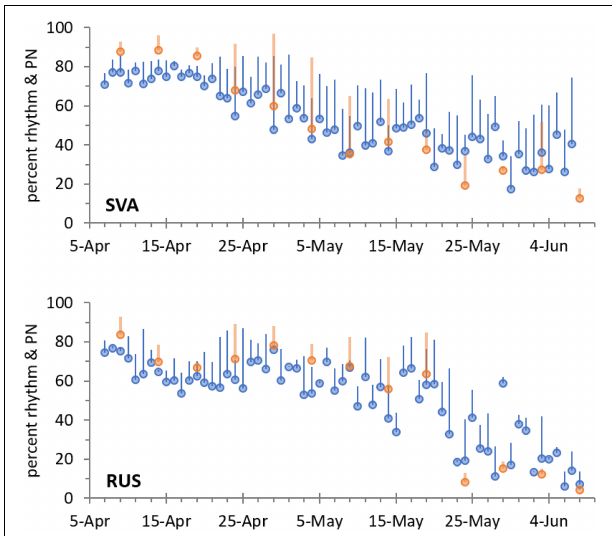
FIGURE 3 | Course of circadian rhythmicity of Tb in barnacle geese during spring, encompassing the time before, during, and after migration to their Arctic breeding grounds in Svalbard (SVA) and Russia (RUS). Plotted are percent rhythm (mean + SD over individuals, blue symbols) calculated from daily cosinor analysis, and normalized power (PN, mean + SD over individuals, orange symbols) at a period length of 24 h calculated from Lomb-Scargle periodogram analyses on 5-day intervals (both left axis).